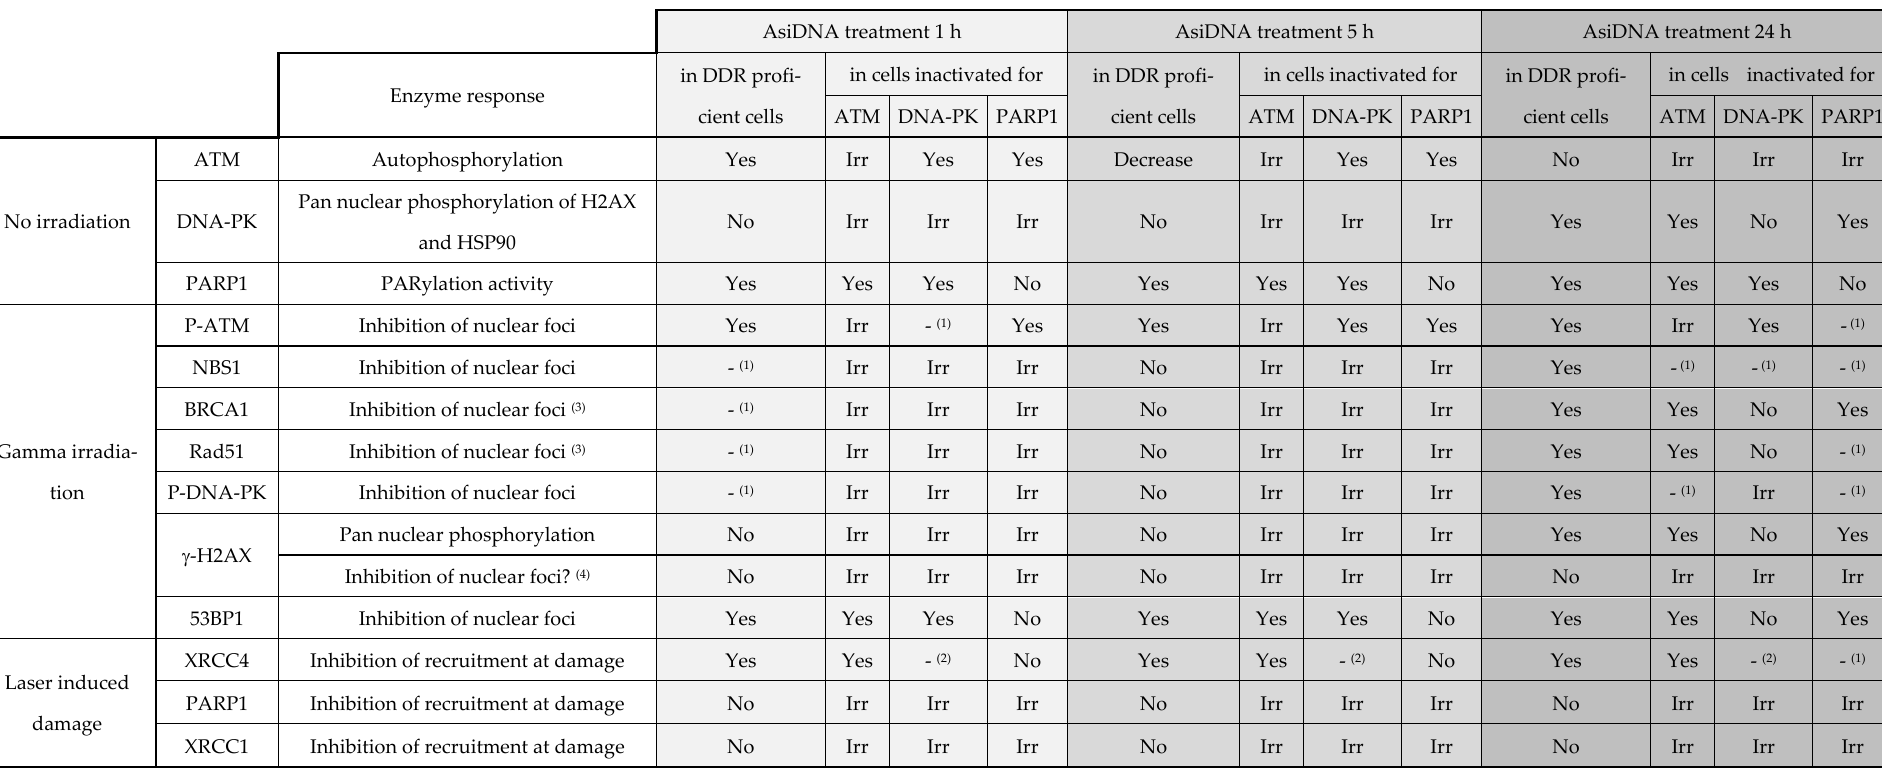
Table 1. Inhibition of repair enzymes recruitment at DNA damage. Cells treated for different times with AsiDNA at 150 µ g/mL were nonirradiated or irradiated at 2Gy for P-ATM, or at 10Gy for the other enzymes. Focus formation was analyzed by immunofluorescence at 10 min (for P-ATM) or 2 h (for the other proteins) after irradiation. All analyses were performed in SK28 and confirmed in at least one other cell line, such as MDA-MB-231, MRC-5sv, Hela, or MO59K. The quantification of foci after irradiation was performed as described in Materials and Methods. Enzyme dependence to ATM, DNA-PK, and PARP1 was estimated by focus quantification in cells treated with ATM inhibitor (KU55933), DNA-PK inhibitor (NU7026), PARP inhibitor (olaparib), or in cell lines carrying mutations or silenced for ATM, DNA-PK, or PARP1.